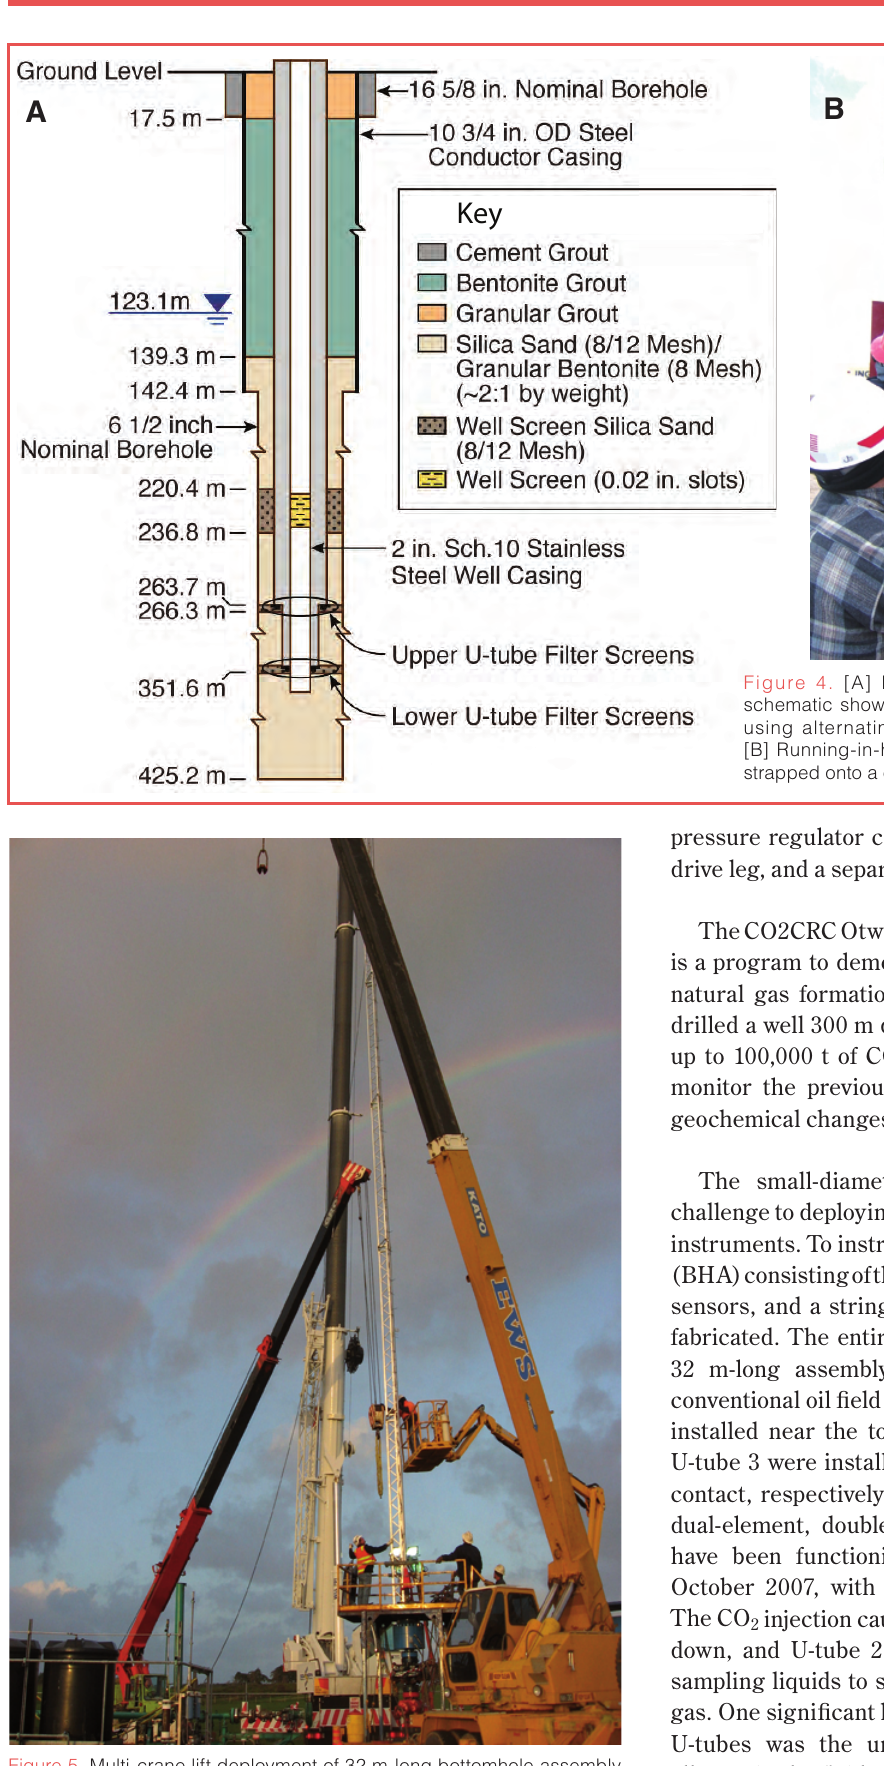
Figure 5. Multi-crane lift deployment of 32 m-long bottomhole assembly consisting of U-tubes, seismic sensors, and pressure temperature sensors at the CO2CRC Otway Project Site, Victoria, Australia.